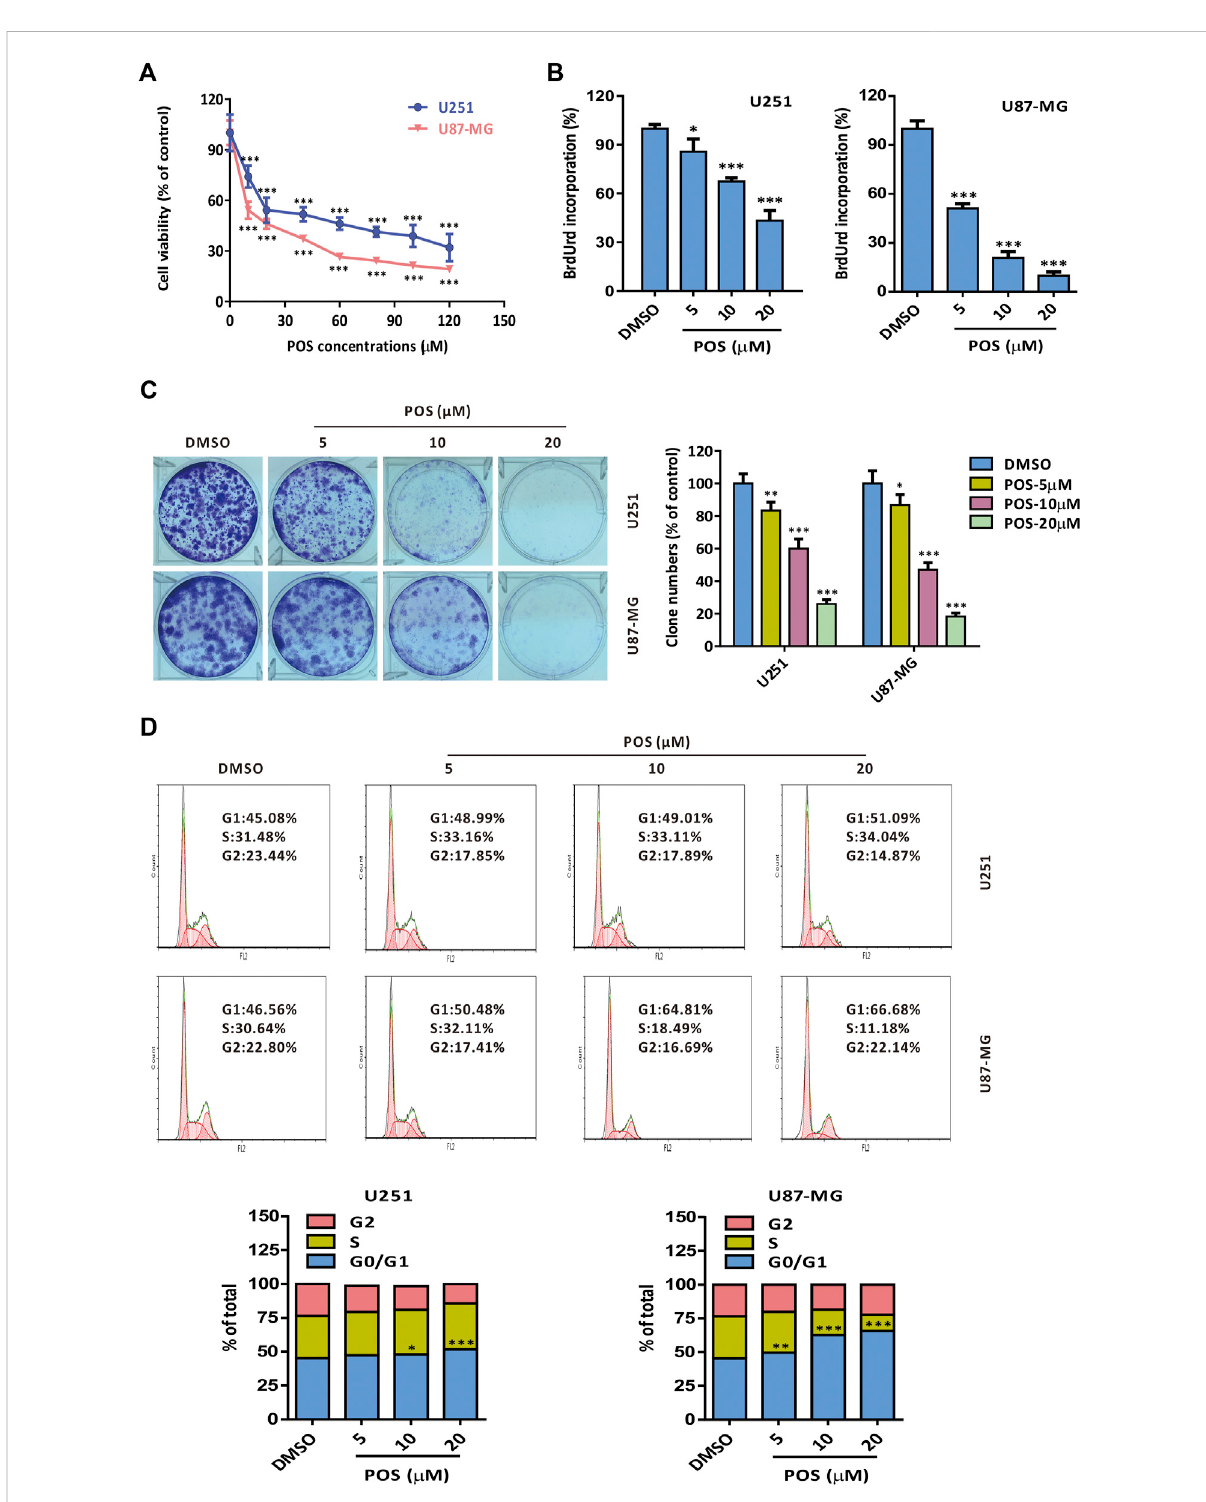
FIGURE 1 POS shows potent cytotoxicity and retards thecell cycleinGBM cells. (A) Cell viability was detectedby CCK-8assay after the cellswere treated as indicated for 24 h. (B) Cellproliferation wasmeasured byBrdU labeling assay after the cellswerehandled as indicated for 24 h. (C) Long-term cell proliferation was observed by colony formation assay after the cells were treated as indicated for 2 weeks. (D) Cell cycle was monitored by a Cell Cycle Detection Kit after the cells were handled as indicated for 24